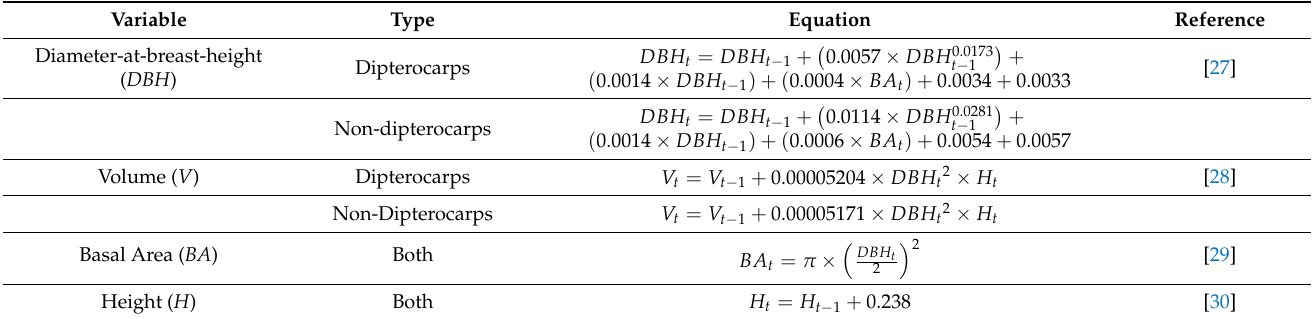
Table 1. Equations used for tree growth.